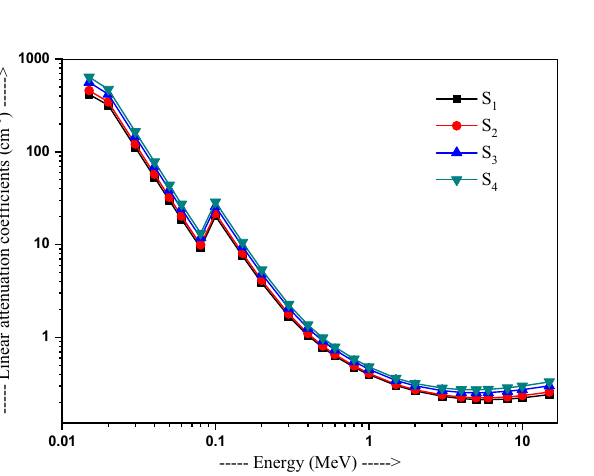
Figure 3. Variation of linear attenuation coefficient with energy in 20Bi 2 O 3 − xPbO − (80 − 2x)B 2 O 3 − xGeO 2 (x = 5, 10, 20, and 30 mol%)